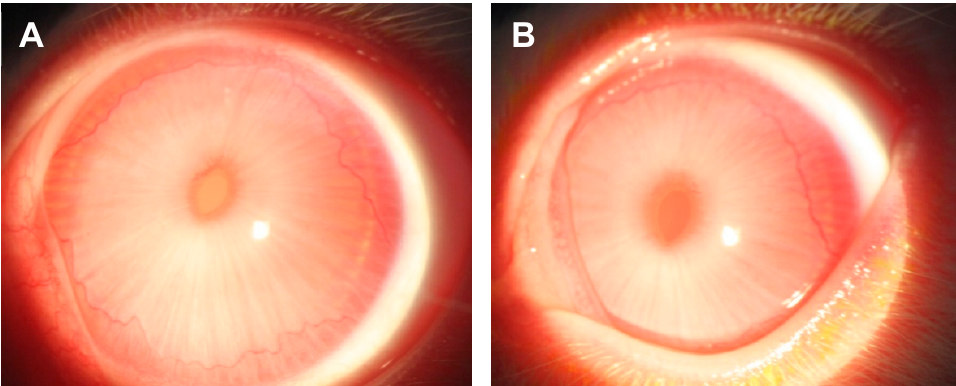
Figure 3. Representative photographs of eyes treated with ( A ) 0.5% FCV and ( B ) vehicle after 4 times daily dosing for 10 consecutive days in the ocular toxicity study.